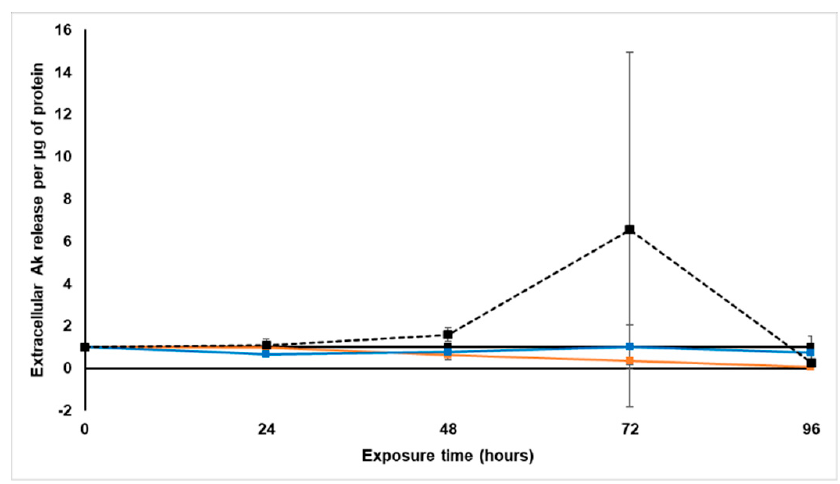
Figure 8. Normalized extracellular adenylate kinase release per microgram protein following ex- posure of the sodium alginate encapsulated LS180 mini-tumor model to Xysmalobium undulatum aqueous extract and paclitaxel. The solid black line represents the untreated control, the black dashed line represents paclitaxel [IC 50 ], the orange line represents X. undulatum [IC 50 ] and the blue line X. undulatum 2[IC 50 ]. All data were normalized to the untreated control group (error bars = standard deviation; n = 6.